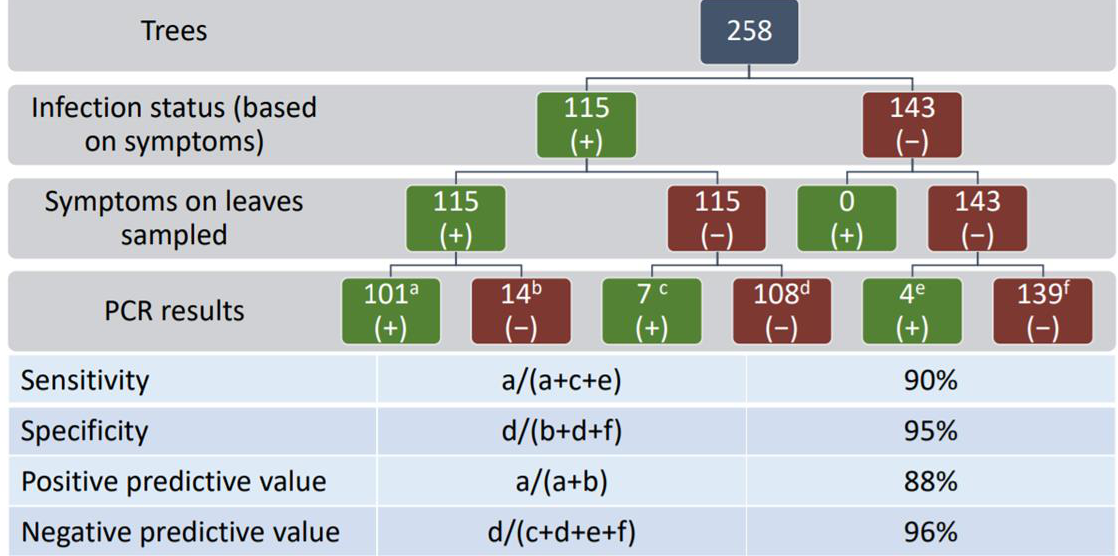
Figure 5. Karaka Ōkahu purepure virus diagnostic test results from 258 trees. Symptomatic and asymptomatic leaves were tested from 115 symptomatic trees and asymptomatic leaves were tested from 143 asymptomatic trees. a RT-PCR positive from a symptomatic leaf; b RT-PCR negative from a symptomatic leaf; c RT-PCR positive from an asymptomatic leaf taken from a symptomatic tree; d RT-PCR negative from an asymptomatic leaf taken from a symptomatic tree; e RT-PCR positive from an asymptomatic leaf taken from an asymptomatic tree; f RT-PCR negative from an asymptomatic leaf taken from an asymptomatic tree. na, not applicable.